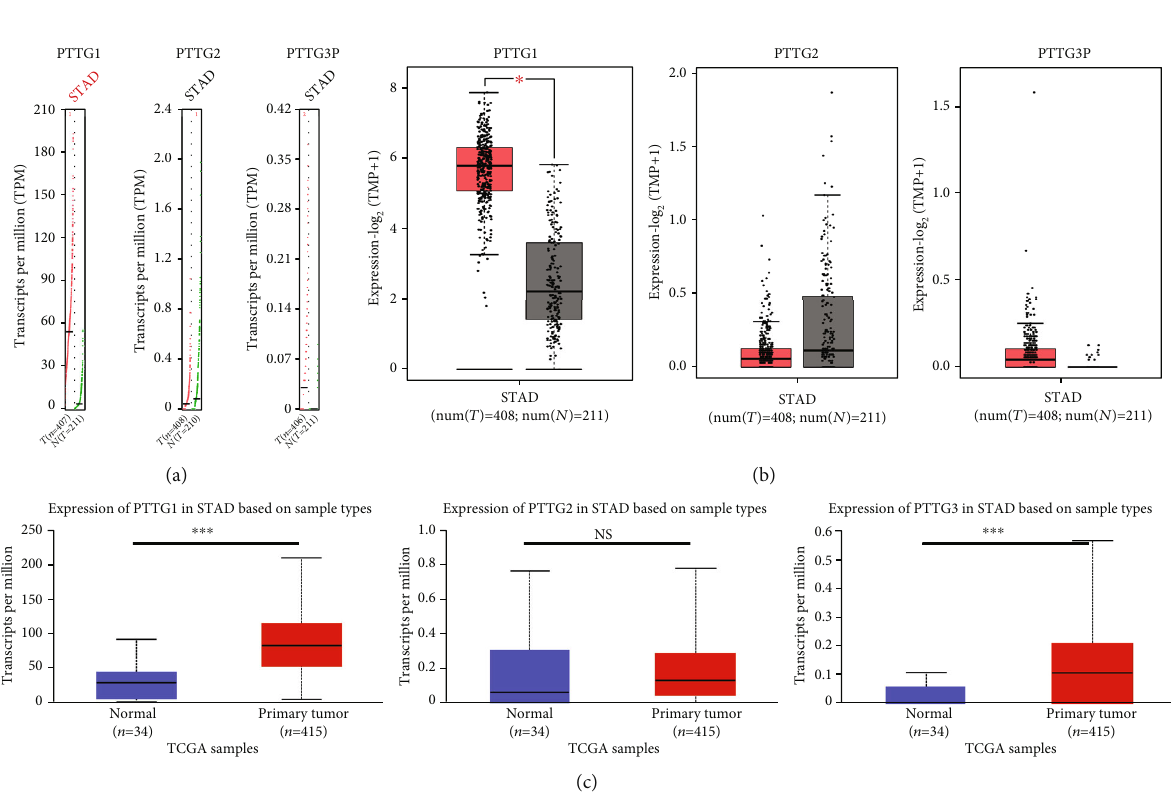
Expression of PTTG2 in STAD based on sample types NS